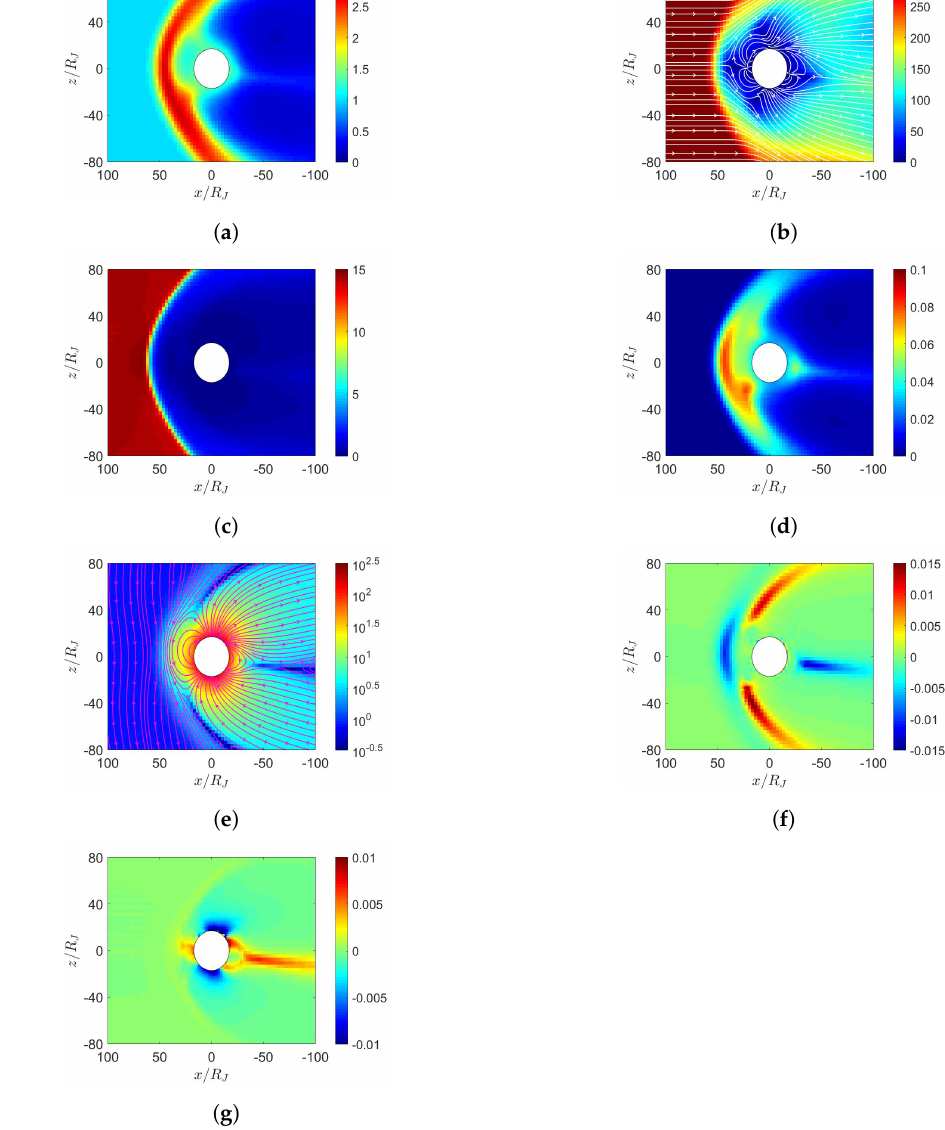
Figure 14. Distributions around Jupiter of ( a ) n (cm − 3 ), ( b ) ¯ u xz (km/s), ( c ) magnetosonic Mach number, ( d ) P (nPa), ( e ) ¯ B xz (nT), ( f ) J y (nA/m 2 ), ( g ) J r (nA/m 2 ); maximum dipole tilt points away from sun at t = 0, under southward IMF, t = 21.19